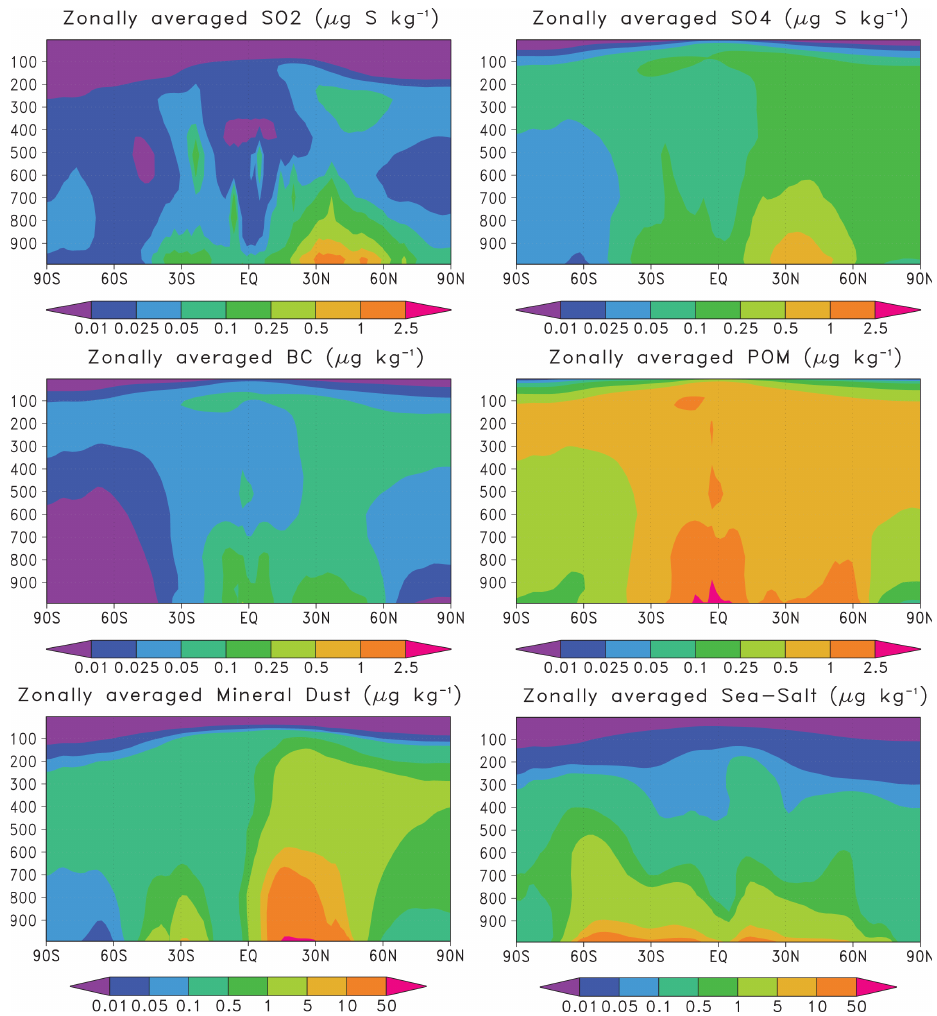
Fig. 3. Annually and zonally averaged mass mixing ratios of SO 2 and aerosol constituents in the Ctrl simulation.